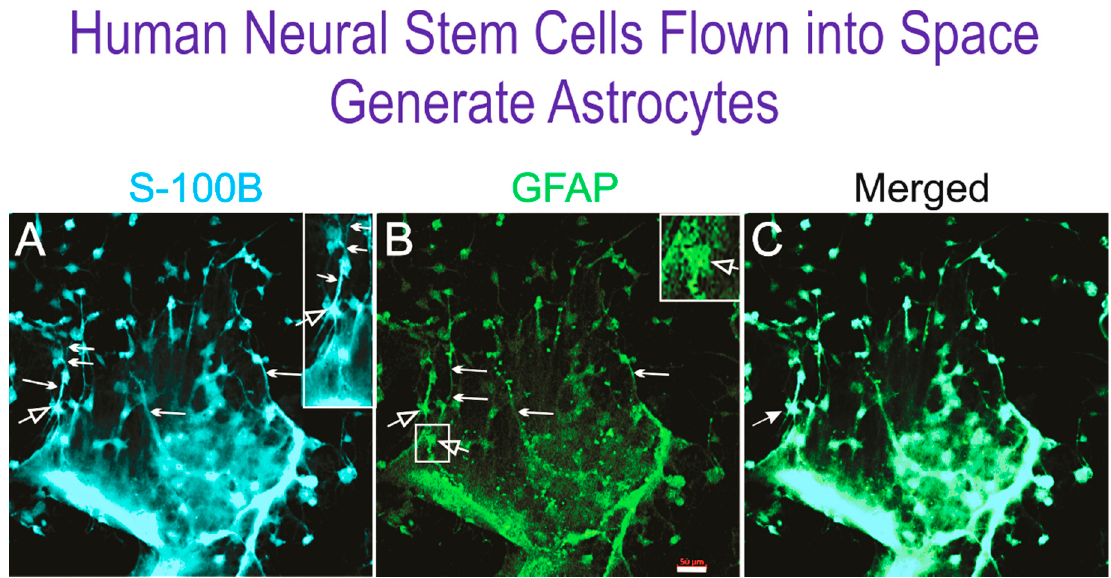
Figure 4. View of NSCs cultured in DF-10% FCS. Virtually all cells in these cultures were positive for ( A ) S-100ß and ( B ) glial fibrillary acidic protein (GFAP). Cells appeared to emanate from a flat layer positive for both markers, and as they were farther from that layer, they extended radial glia-like cell processes (arrows). Scale bar = 50 µm.